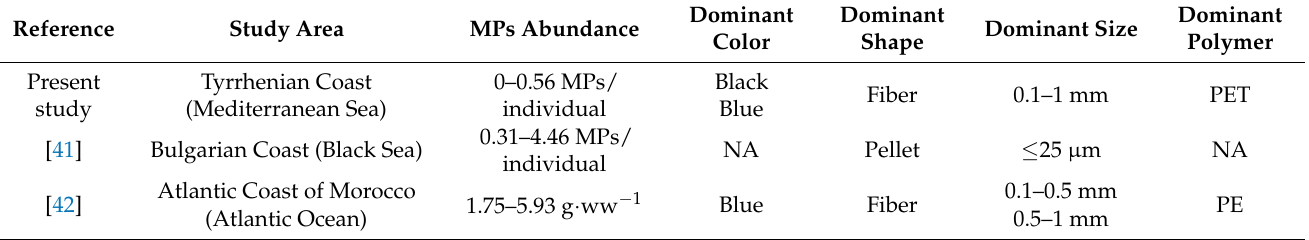
Table 2. Microplastic contamination in the species Donax trunculus across worldwide coasts. The data reported regarding the study area, microplastic abundance, and dominant color, shape, size, and polymer. NA = not available; PET = polyethylene terephthalate; PE = polyethylene.